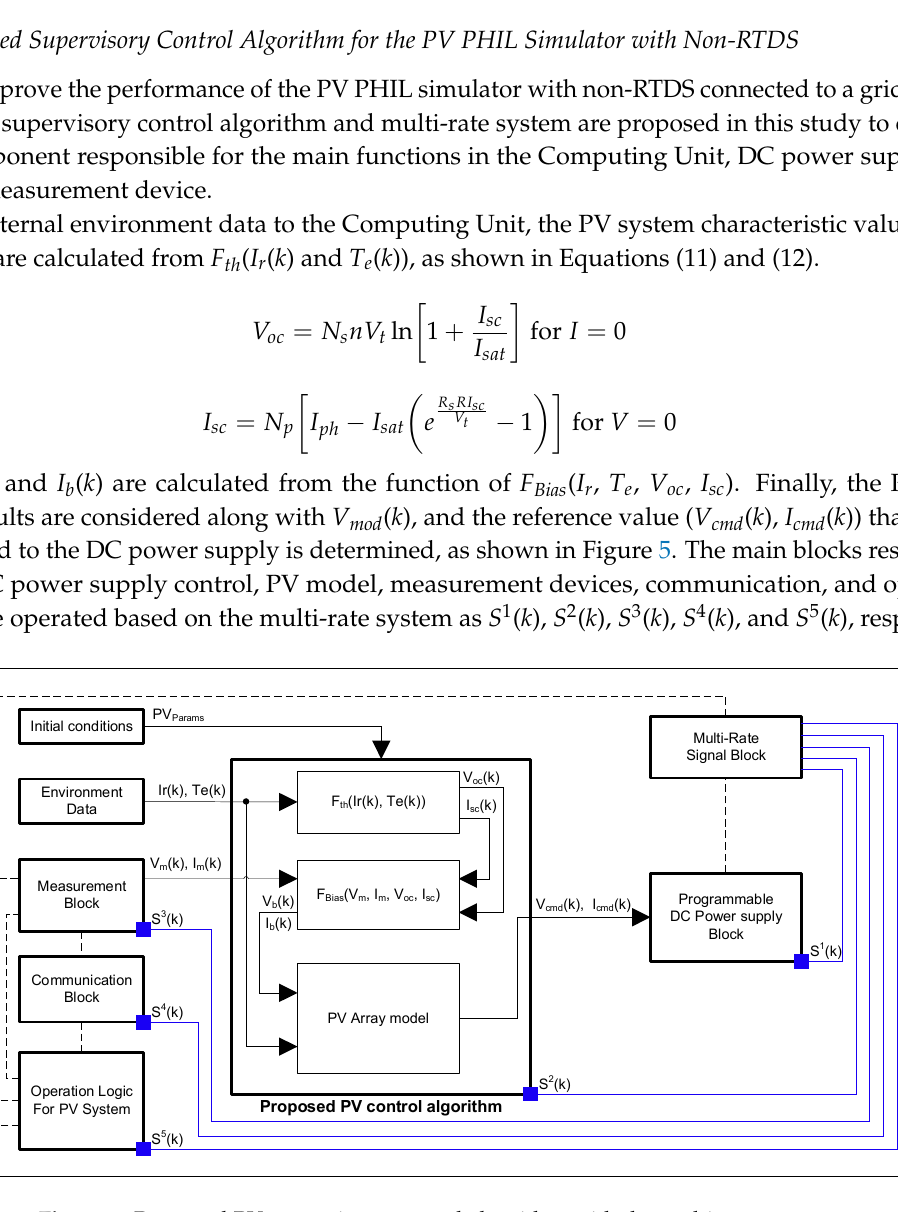
Figure 5. Proposed PV supervisory control algorithm with the multi-rate system.